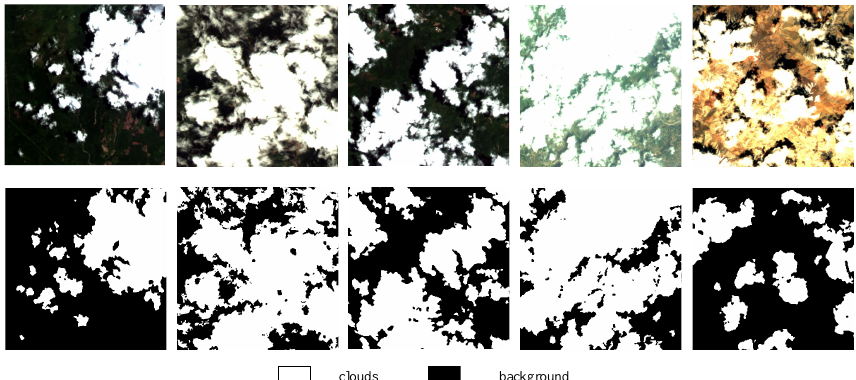
Figure 4. Example annotations of slices in GaoFen-1